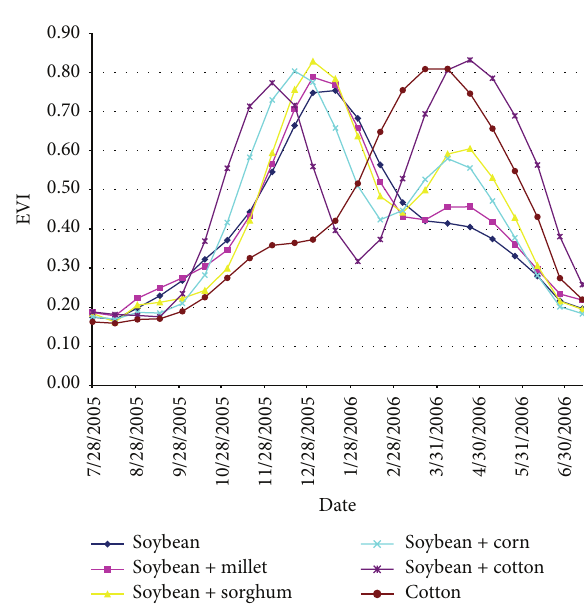
Figure 3: Mean MODIS/EVI time series for selected agricultural plots